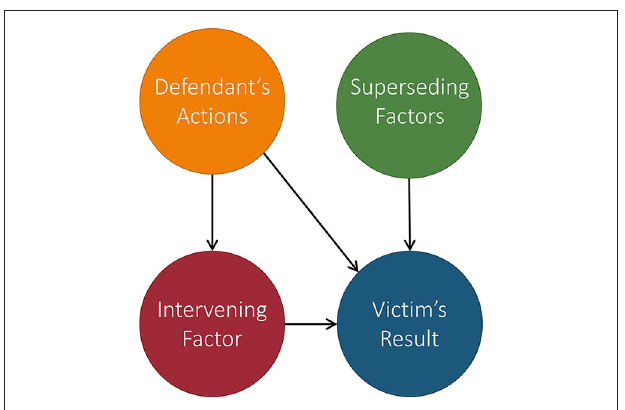
FIGURE 7 | Graphical model displaying the causal relationships between the defendant’s actions, the victim’s result, along with intervening and superceding